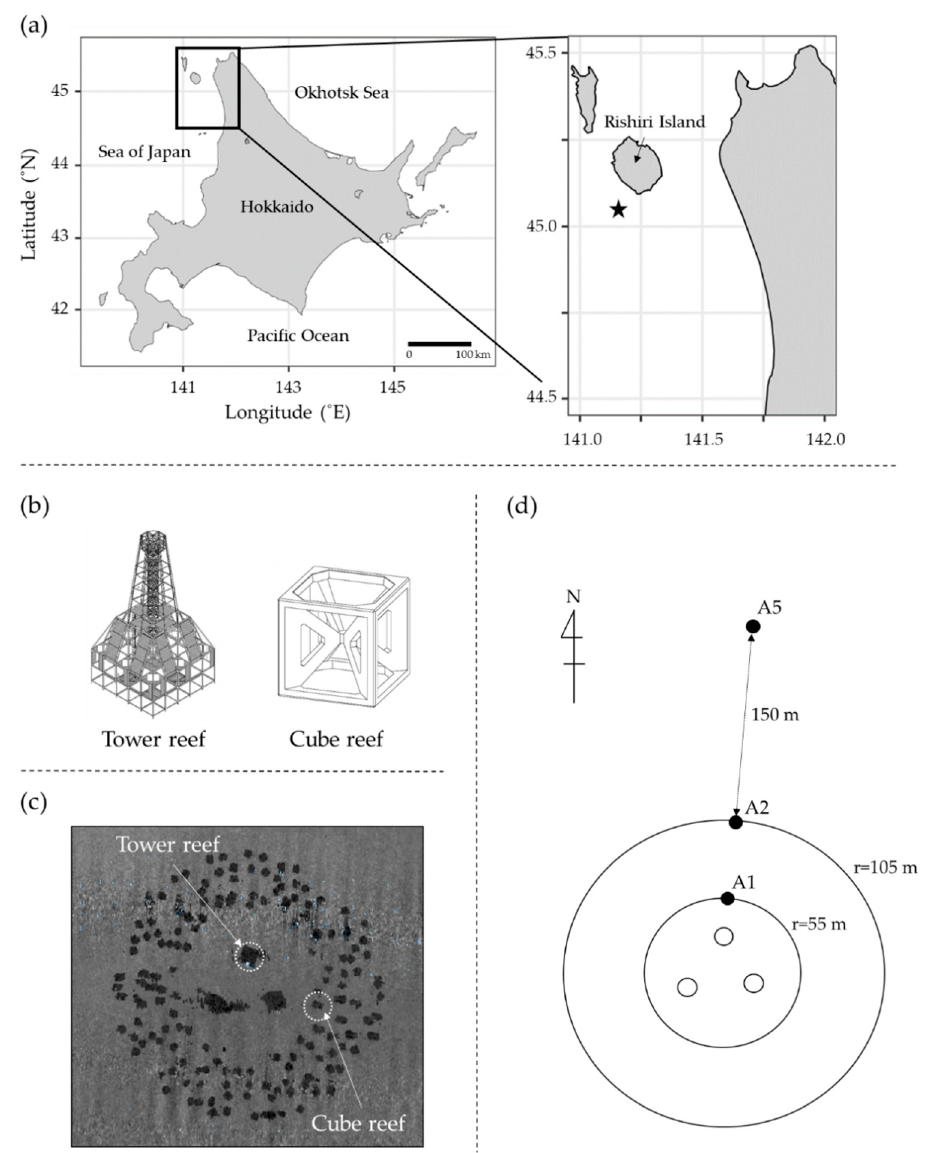
Figure 1. Location of the study area and details of the artificial reef (AR) system: ( a ) location of the AR system (black star), ( b ) detailed structure of a tower reef (20 m high), and a cube reef (3 m high) deployed in the AR system, ( c ) the distribution of tower reefs and cube reefs in the AR system detected by side-scan sonar, and ( d ) location of the sampling stations (A1, A2, and A5); an open circle represents a tower reef.